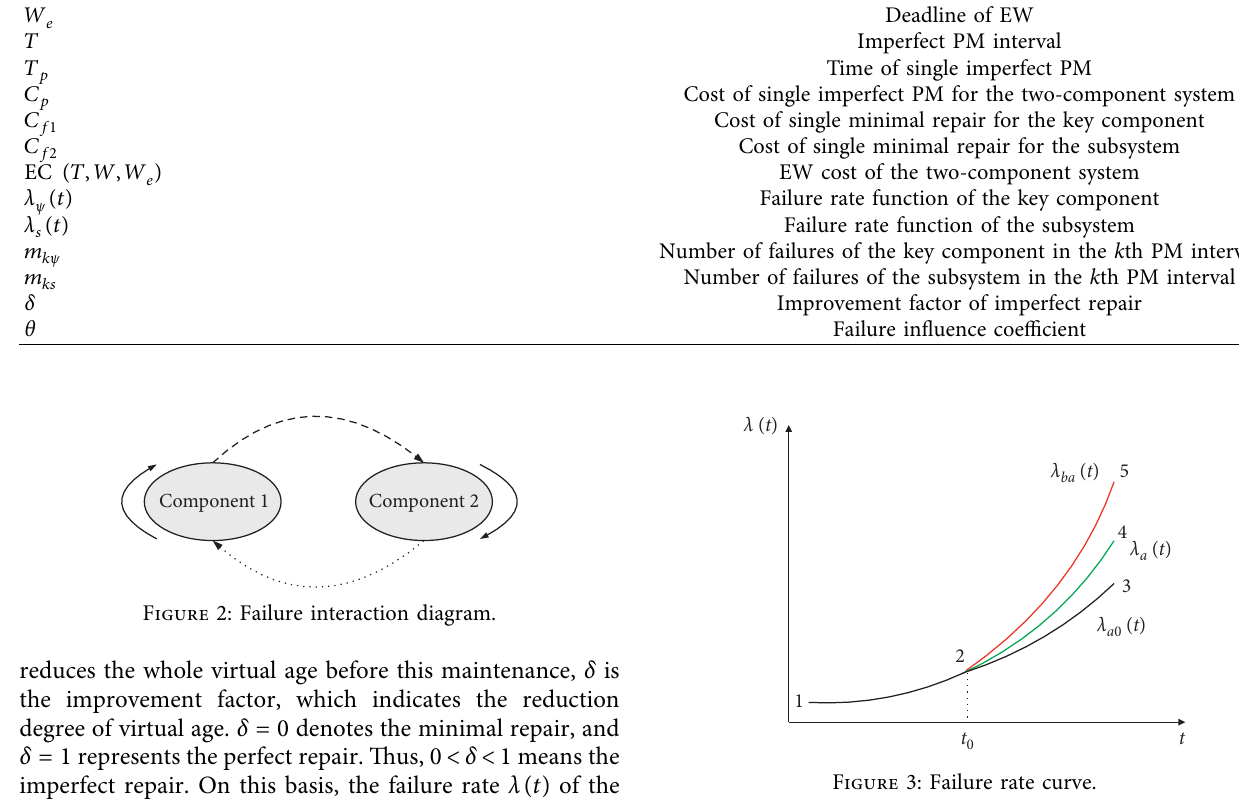
Figure 3: Failure rate curve.